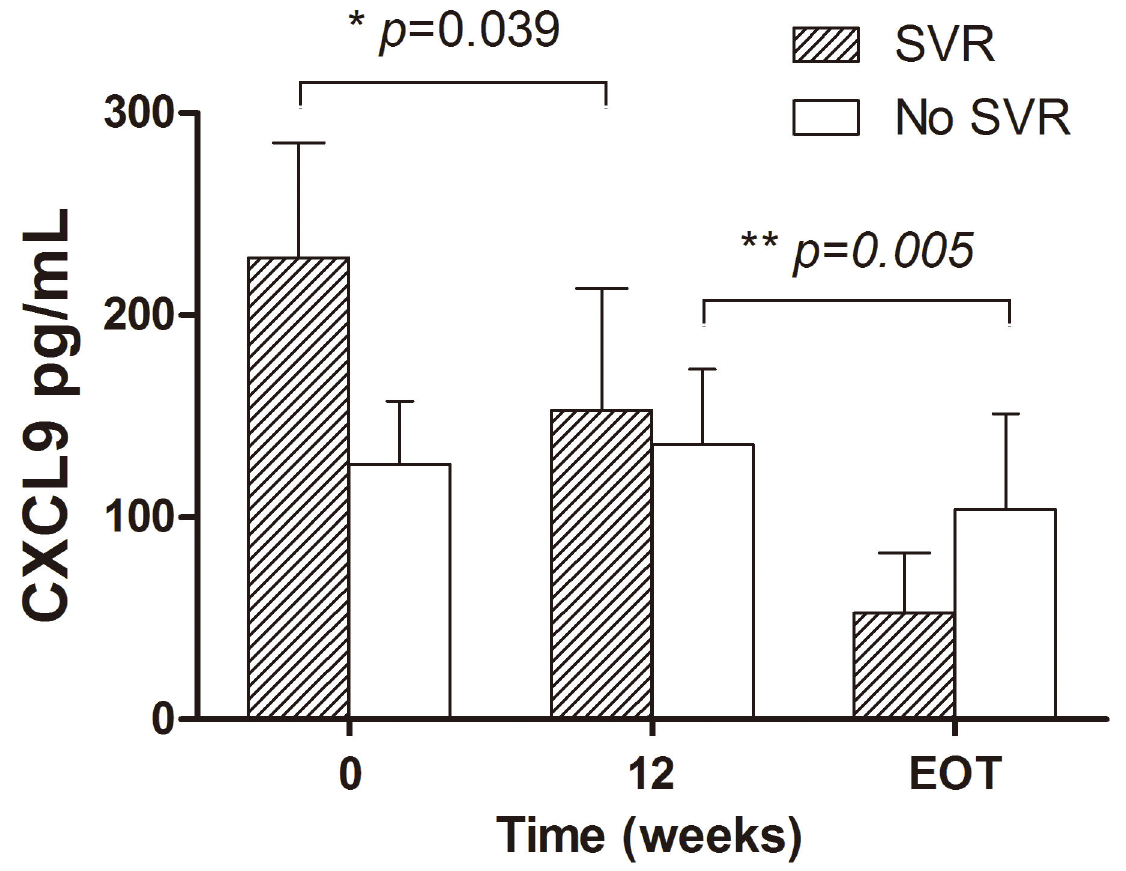
Figure 1. Kinetics of serum CXCL9 levels during PEG-IFN treatment in CHB patients with or without SVR. In patients with SVR, CXCL9 levels significantly decreased from baseline to week 12, whereas in patients without SVR, CXCL9 levels remained high at week 12 but decreased later from week 12 to EOT. Data were presented as mean ± standard errors of the means (SEM). EOT: end of